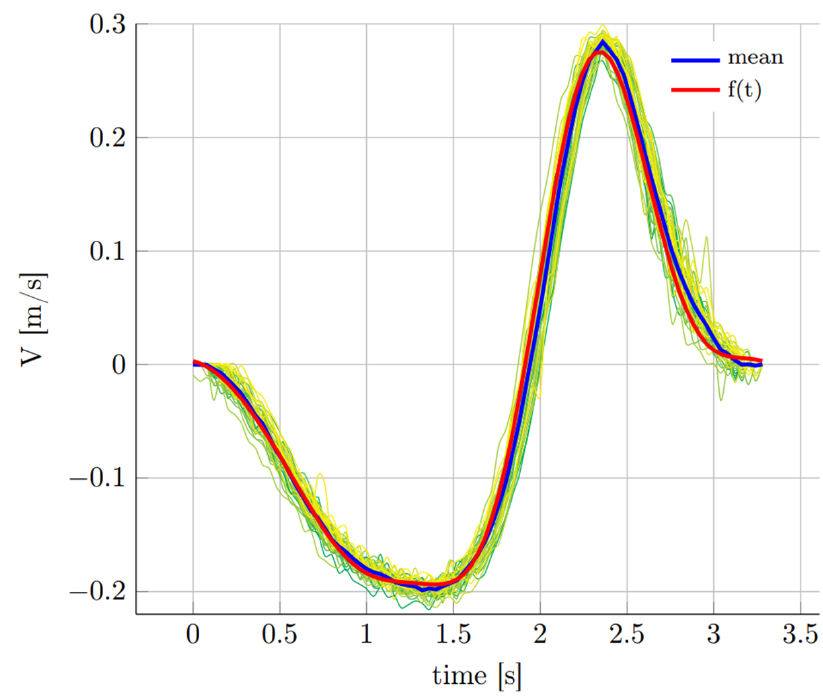
Figure 7. Characteristic records of the along-flume particle velocities.